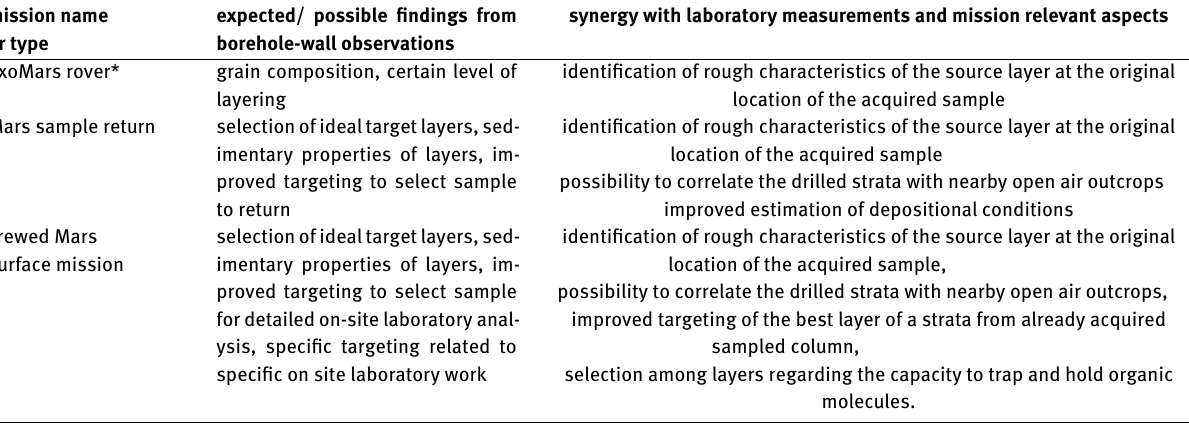
Table 7. Summary of potential contribution of borehole-wall imaging in next Mars missions. The * marks the ExoMars 2020 mission, where no optical but only infrared borehole-wall scanning is planned, thus its potential findings are listed here, while for the other candidate mission types the optical version was